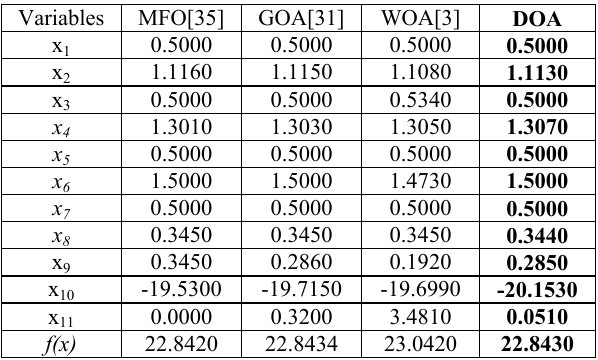
Table 3. Comparison of results for the car side impact